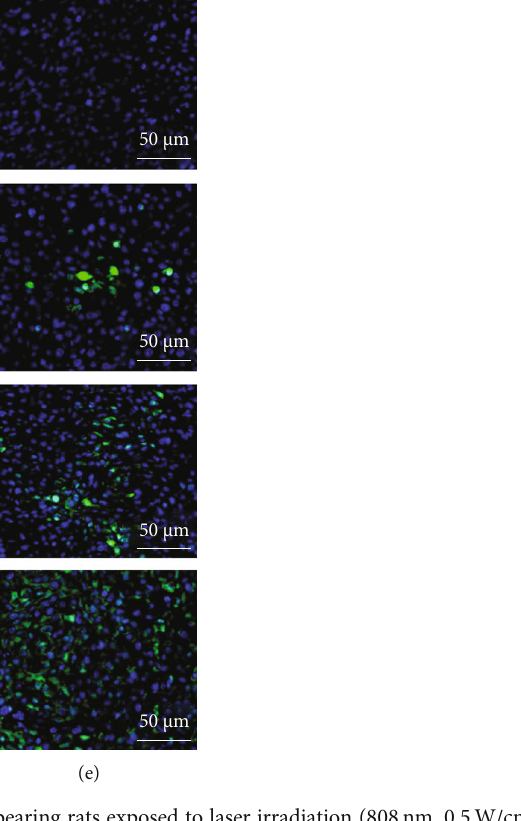
Figure 5: (a) Real-time infrared thermal images of tumor-bearing rats exposed to laser irradiation (808nm, 0.5W/cm 2 ) 10 hours after the injection of SPIOCs@HSA(PTX)-RGD NPs; (b) in vivo tumor growth curves of the glioma-bearing mice after the di ff erent treatments ( ∗ P < 0 : 05 , ∗∗ P < 0 : 01 ); (c) tumor weights measured after the various treatments ( ∗∗ P < 0 : 01 ); (d) oxidative stress detected by ROS probe; (e) TUNEL-stained tumor slices taken at day 4; groups from top to bottom are PBS, SPIOCs@HSA(PTX), SPIOCs/@HSA(PTX)-RGD, and SPIOCs@HSA(PTX)-RGD+808 nm irradiation,